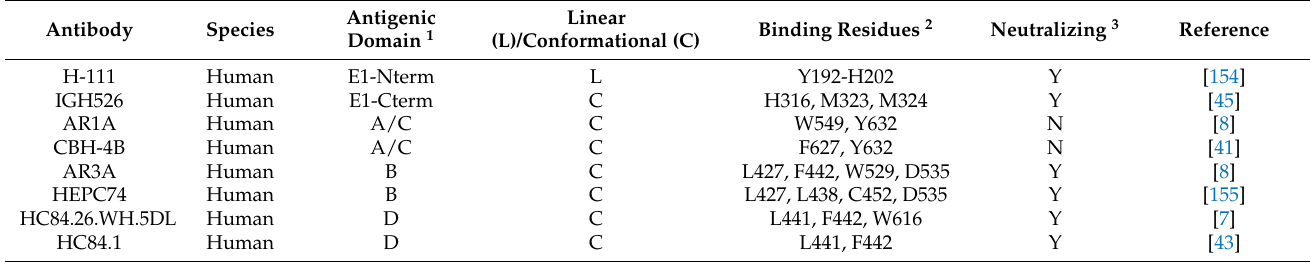
Table 1. HCV comprehensive mAb